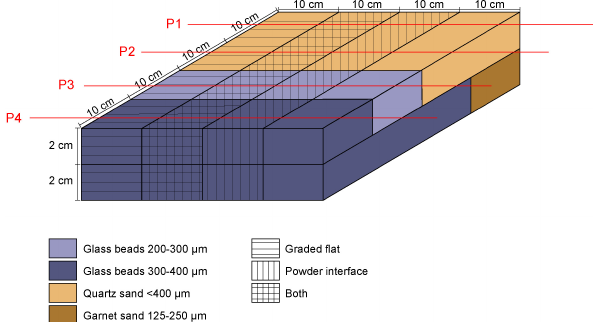
Fig. 5. Setup of the interface model to test seismic imaging prop- erties of selected granular materials and of differently prepared in- terfaces. The lines labelled P1–P4 mark the locations of the seismic sections shown in Fig.